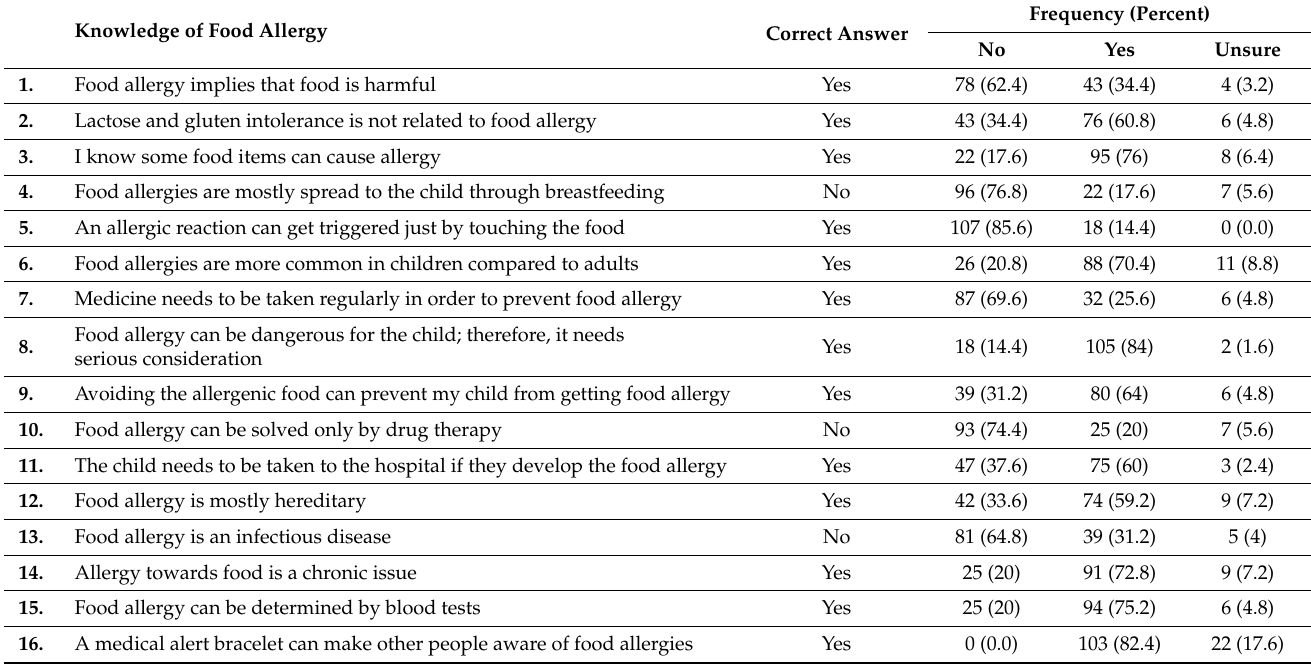
Table 4. Knowledge of parents on food